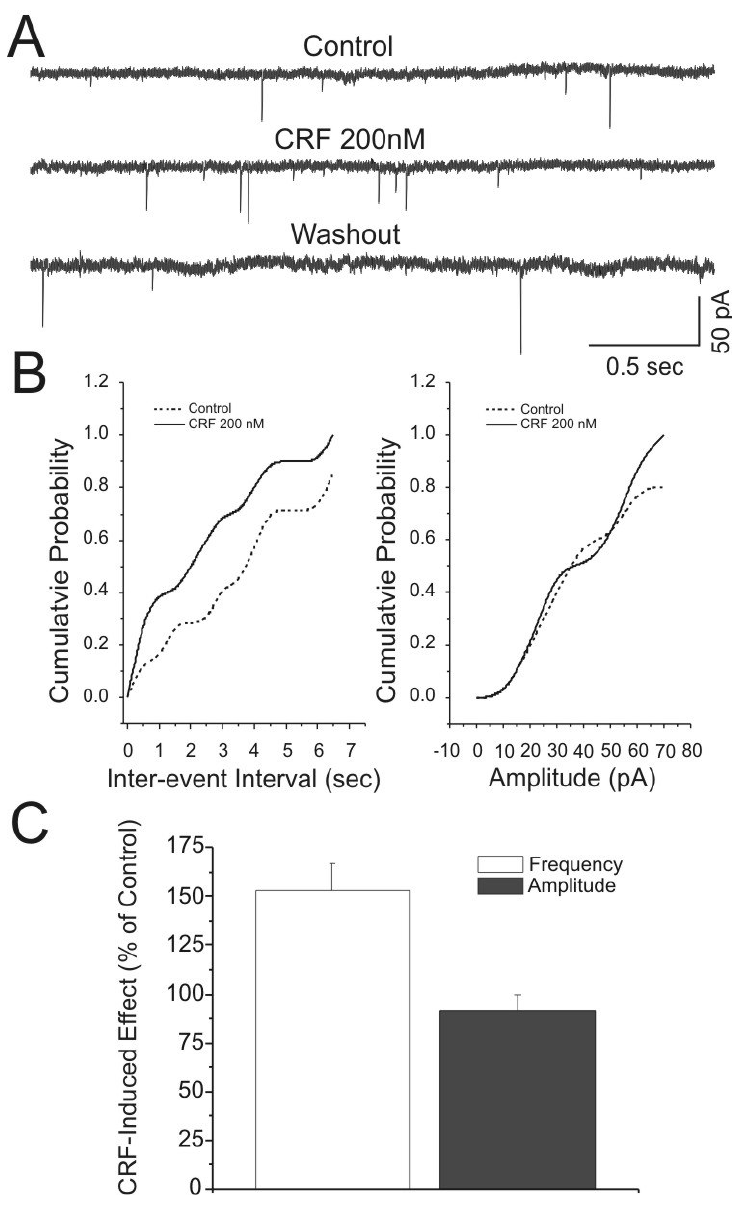
FIGURE 7. CRF increases the frequency of mIPSCs in WT murine CeA neurons recorded using the “blind patch” whole-cell configuration. All recordings performed in the presence of glutamate (DNQX 20 µ M and APV 30 µ M ) and GABA B (CGP 1 µ M ) receptor antagonists and of 1 µ M TTX. (A) Representative current traces of mIPSCs from a CeA neuron with low baseline mIPSC frequency, showing that superfusion of 200 n M CRF (3 min) increased mIPSC frequency, with recovery after 9 min of washout (bottom trace). This neuron was held at –60 mV throughout the experiment. Number of recorded events: Control, 9; CRF, 14; washout, 6. (B) Cumulative event histograms of the same CeA neuron as in (A). Left panel: CRF increased the cumulative probability of mIPSCs with short inter-event intervals (greater frequency), with no effect on mIPSC amplitudes (right panel). (C) Pooled data from five WT mouse CeA neurons; 200 n M CRF significantly ( p = 0.002) increased mean mIPSC frequency (by over 50%), but had no significant effect on mean mIPSC